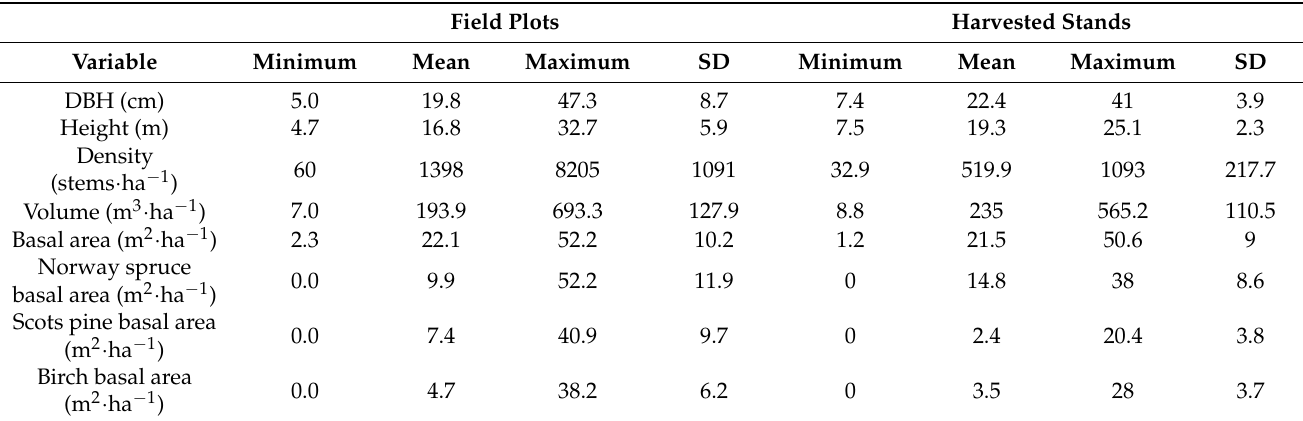
Table 1. Forest structure within the 665 field plots and the 249 harvested stands. Field